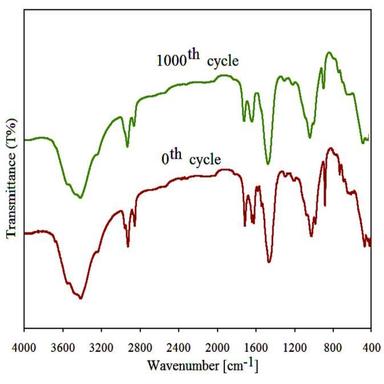
FT-IR spectra of Sep/FAEM(42 wt%) after 1000 cycles.